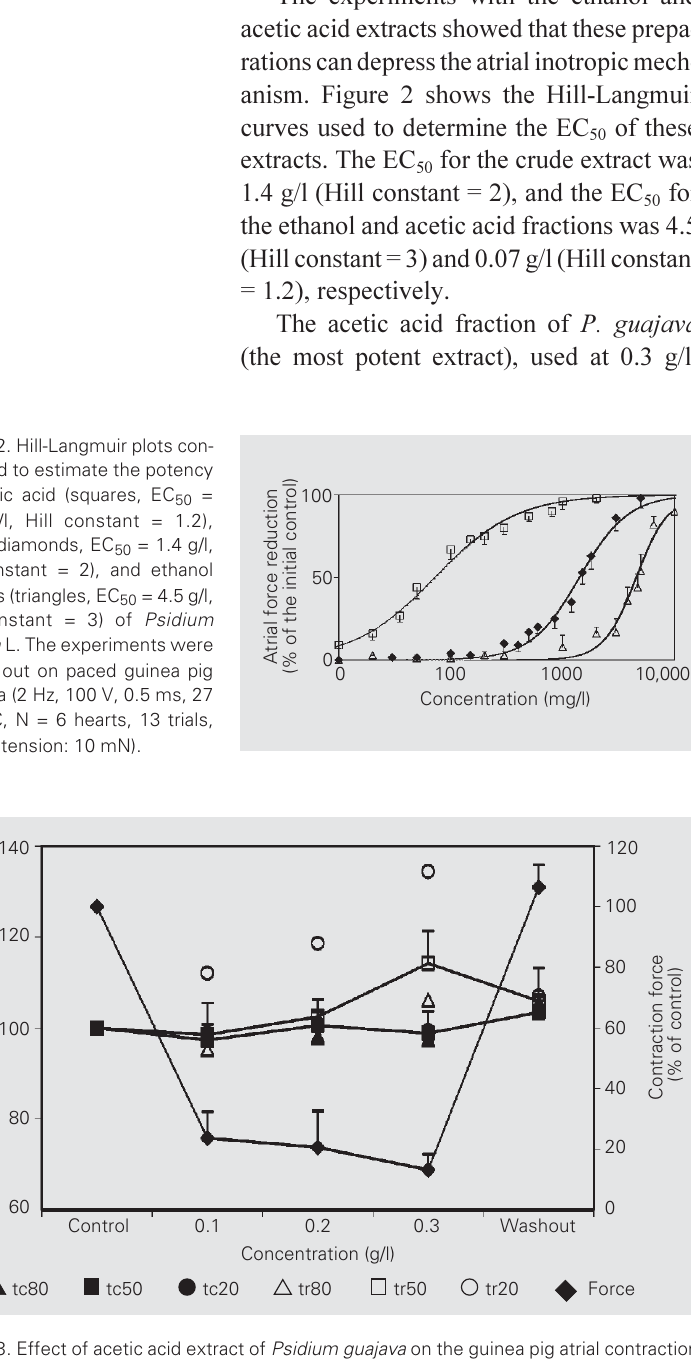
Figure 3. Effect of acetic acid extract of Psidium guajava on the guinea pig atrial contraction (tc80, tc50, tc20) and relaxation (tr80, tr50, tr20) times. Times were measured at different levels of the force amplitude (80, 50, and 20%). The extract did not significantly change the contraction times, but increased the relaxation times when used at 0.3 g/l. This effect was more evident at the lowest force level (20%, open circles). The effect of P. guajava on the force amplitude (diamonds) is illustrated as reference (N = 3, 6 trials, 27 ± 0.1 (cid:1) C, 2